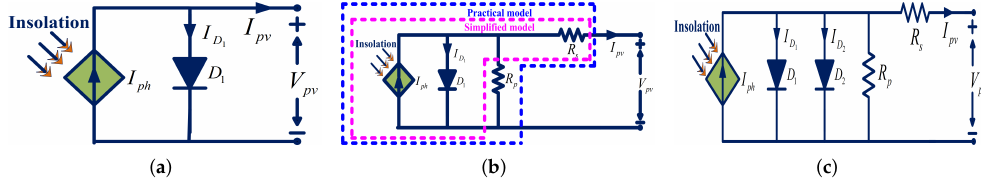
Figure 1. PV module equivalent circuits. ( a ) Ideal model, ( b ) simplified and practical model, and ( c ) two-diode